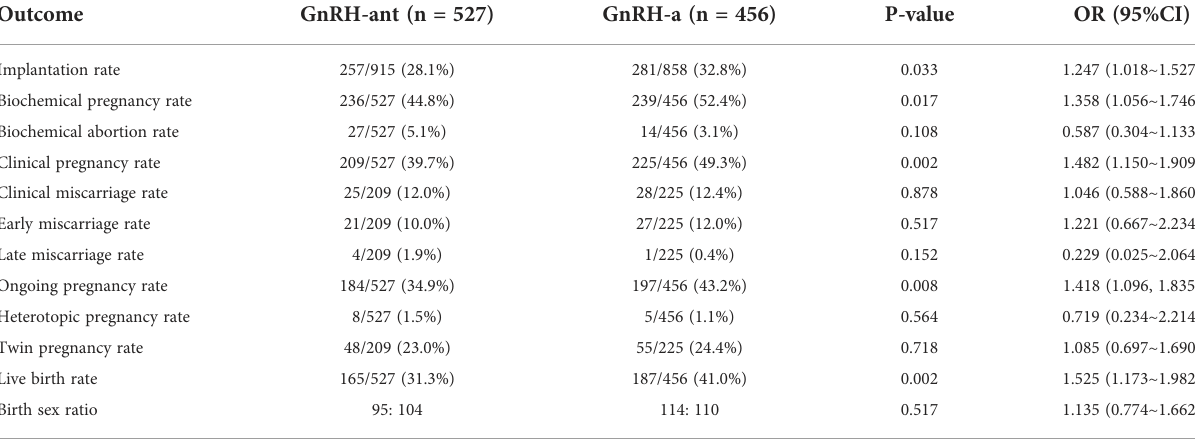
TABLE 3 Comparison of the treatment outcomes for patients with severe male factor infertility.